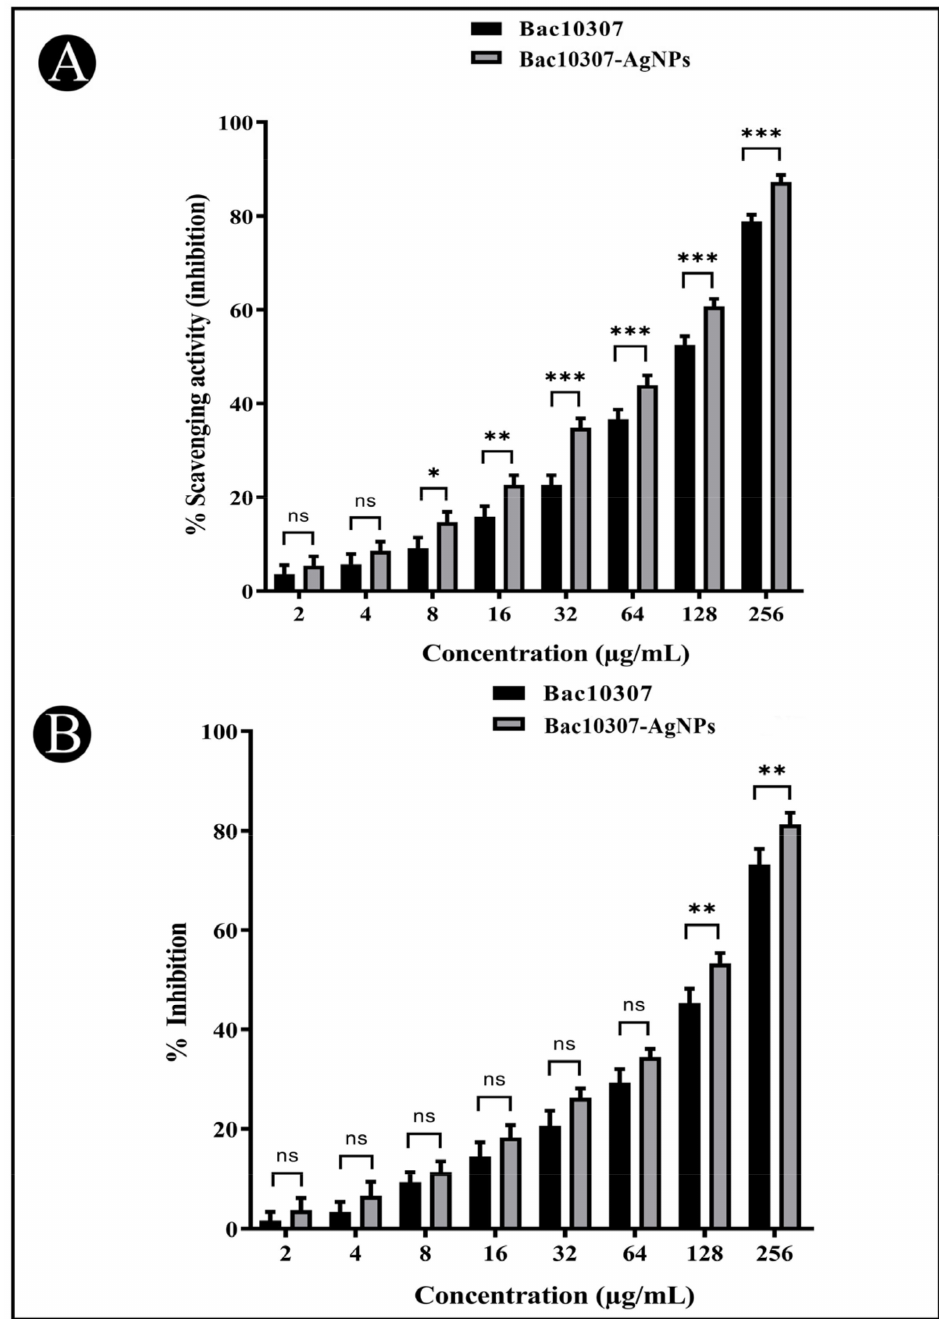
Figure 5. ( A ). Antioxidant activity of Bac10307 and Bac10307-AgNPs against DPPH free radicals. ( B ) Cytotoxicity of Bac10307 and Bac10307-AgNPs against HepG2 cancer cells. The test was carried out in triplicate, and the data represent the mean ± SD, n = 3. Significance; ns > 0.05, * p < 0.05, ** p < 0.01, *** p <